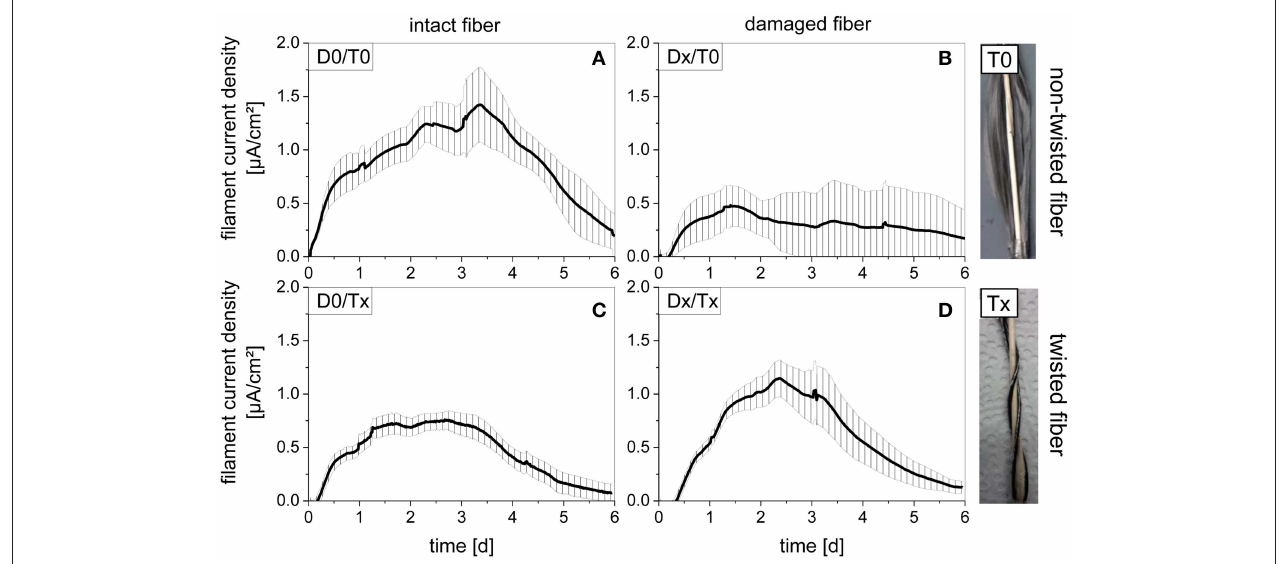
FIGURE 4 | Current density normalized to combined filament surface in single fiber BES (HTS40CM); (A,C) intact fibers and (B,D) fibers with introduced breaks. Legend: D0, intact; Dx, damaged; T0, non-twisted (A,B) ; Tx, twisted yarn (C,D) . One electrode consists of two 6cm fiber pieces. Shown are average values and standard deviations from 6 replicates. Photographs (taken by F. Schmitz) show a representative fiber electrode for non-twisted yarns T0, i.e., open display of filaments, and twisted yarns Tx, which resemble commercial twisted